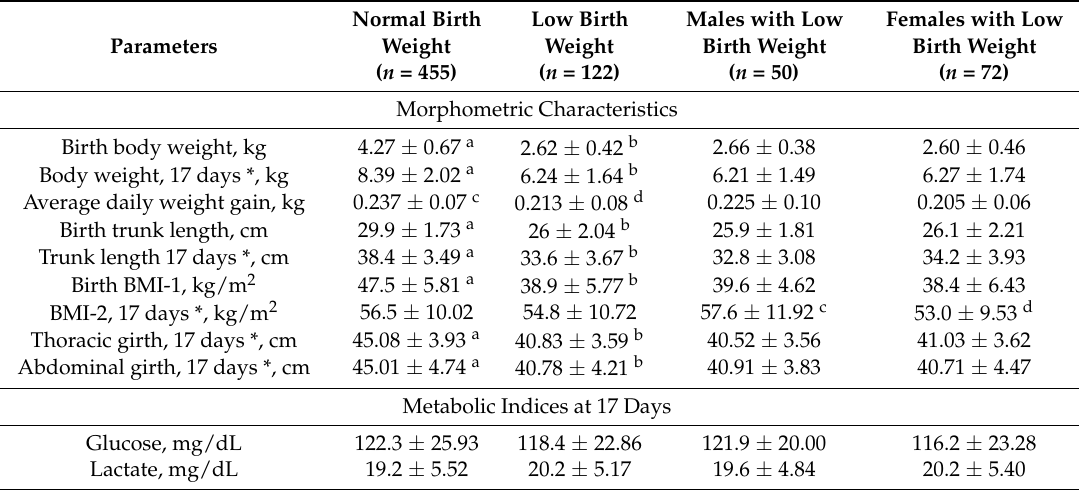
Table 3. Morphometric measurements and metabolic status of lambs, stratified by birth weight and sex.